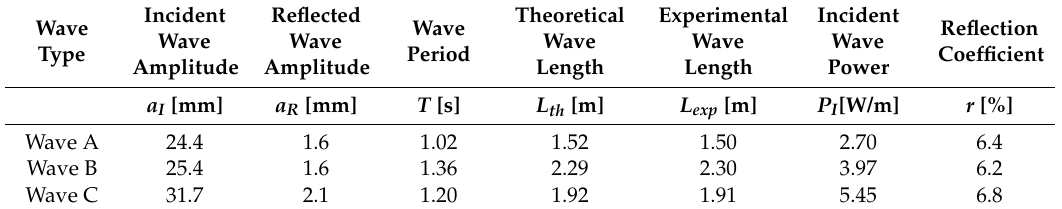
Table 2. Laboratory waves.